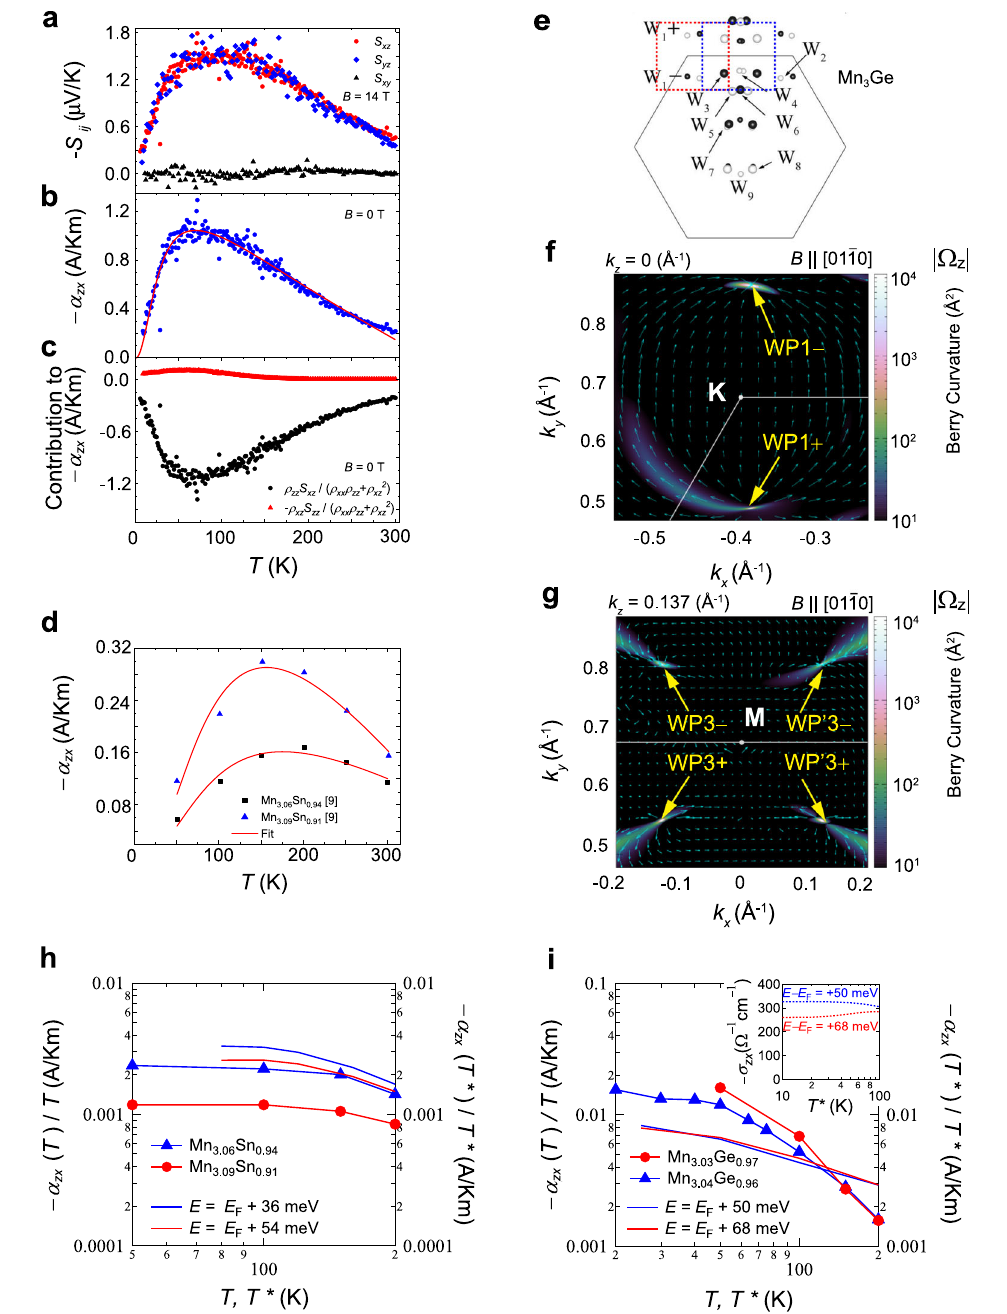
Fig. 4 Transverse thermoelectric effects in Mn 3 X ( X = Sn, Ge) and their theoretical analyses. a – c Temperature dependence of the Nernst coef fi cient, (cid:2) S B = 14 T. S S S fi nitions are modi fi ed from the original ones in ref. 15 ij , measured under zx (red circle), yz (blue diamond), and xy (black triangle). The label de so that they become consistent with the results obtained by other groups. a Zero- fi eld anomalous transverse thermoelectric conductivity, (cid:2) α xz , with the best fi t to the minimal model of Weyl fermions (solid line) ( b ), and the two contributions to (cid:2) α xz ( c ) in Mn 3 Ge. d Temperature dependence of (cid:2) α xz in (cid:1) (cid:3) Mn 3.06 Sn 0.94 and Mn 3.09 Sn 0.91 from ref. 9 . e k -space distribution of the Weyl points (W 1 – W 9 ) under B k 0 (cid:1) 110 predicted by the DFT calculation in ref. 30 . The red and blue frames mark the W 1 and W 3 pairs that are consistent with the WP1 ( f ) and WP3 (WP ′ 3) ( g ) pairs revealed by our calculation. Contour (cid:1) (cid:3) plots of the theoretical Berry-curvature spectrum | Ω z | in the k x – k y -plane under B k 01 (cid:1) 10 at k z = 0 (Å − 1 ) ( f ) and at k z = 0.137 (Å − 1 ) ( g ). The arrows indicate the Berry curvature arising from the WP1 ( f ) and WP3 (WP ′ 3) ( g ) pairs. Each pair consists of two Weyl points with opposite chirality. Experimental (cid:2) α zx = T (solid symbols) vs. theoret i cal curves obtained from the DFT calculations for Mn 3 Sn ( h ) and Mn 3 Ge ( i ). Calculations are made with the energy shifts in the chemical potential corresponding to the extra Mn in the off-stoichiometric samples, relative to the Fermi level E F of the stoichiometric case (i.e., E = E F ). A convergence factor of γ = 0.02 and a coef fi cient AZ 2 = 5.0 eV − 1 are used in the calculation. The renormalized temperature T * = T /5 for Mn 3 Sn is set accordingly to the ARPES results. A smaller renormalization factor T * = T /2 is chosen for Mn 3 Ge given its larger bandwidth relative to that of Mn 3 Sn. The inset of ( i ) shows the calculated Hall conductivity (cid:2) σ zx for Mn 3.06 Ge 0.94 and Mn 3.03 Ge 0.97 using the same parameters. Adapted from ref. 15 , APS ( a – d